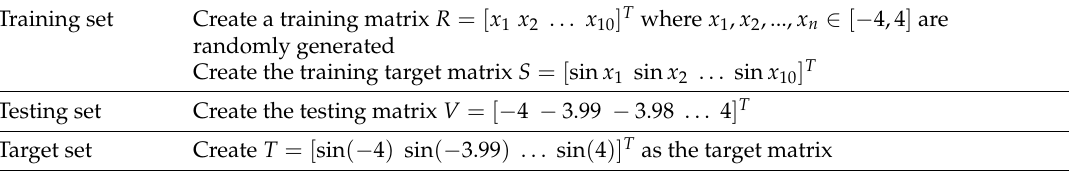
Table 1. Detail about the regression of a sine function